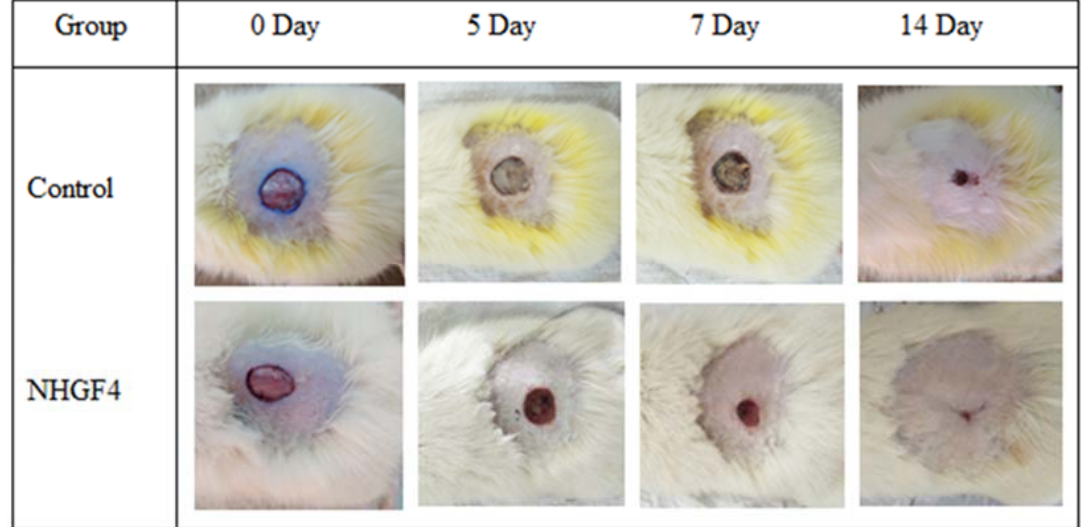
Figure 10. Image showing in vivo (wound healing) activity of Negative Control (Group I) and SNPs embedded with NHGF4 (Group II).